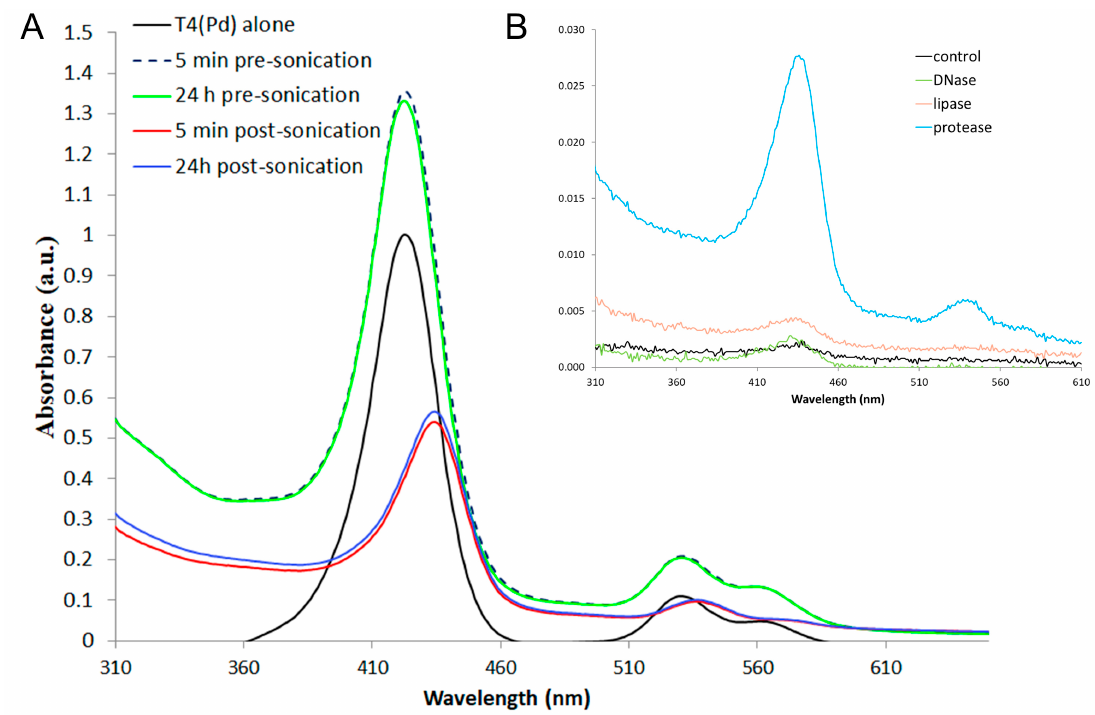
Figure 6. Macromolecule binding of metalloporphyrin Pd(T4). ( A ) C918 cells were incubated with 10 µM of Pd(T4) in a T25 flask for 5 min or 24 h before harvesting the cells. Cells were pelleted and cell-free supernatants as well as porphyrin alone were analyzed by spectrophotometry to determine the absorbance spectrum. To determine porphyrin binding within cells, pellets were resuspended in phosphate buffered saline (PBS) and sonicated followed by centrifugation. Supernatants post-sonication were analyzed to compare bound porphyrin at 5 min compared to 24 h pre-treatment. ( B ) The insoluble pellet was further characterized by being resuspended in PBS and divided into four equal volumes. Each vial was treated differently—PBS alone (control), phospholipase (lipase), DNase, or trypsin (protease)—followed by centrifugation. Absorbance spectrums were determined of supernatants.